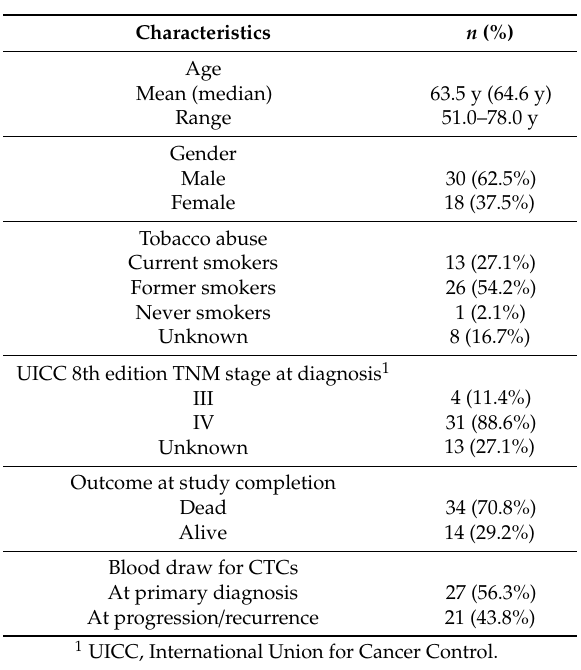
Table 1. Characteristics of 48 small ‐ cell lung cancer (SCLC) patients included in the study.